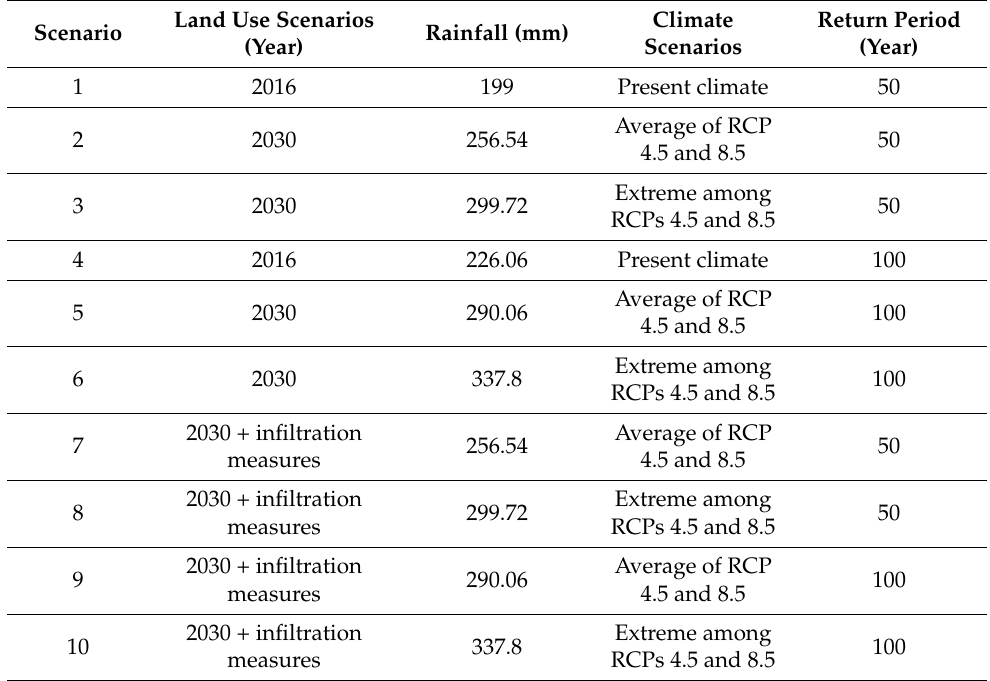
Table 2. Description for various land use and climate change